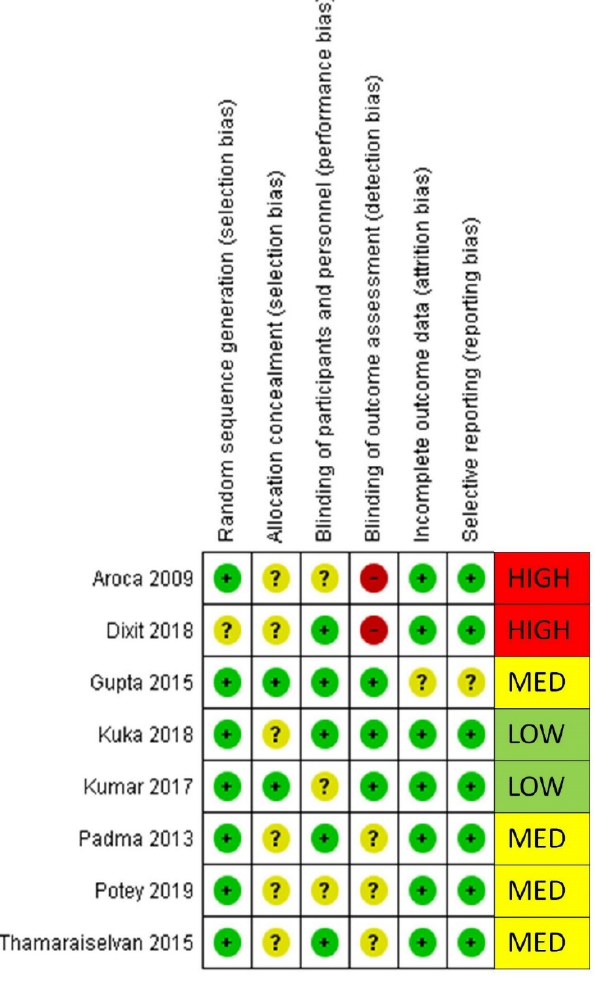
Figure 7. Risk of bias summary: review authors’ judgments about each risk of bias item for each included study.